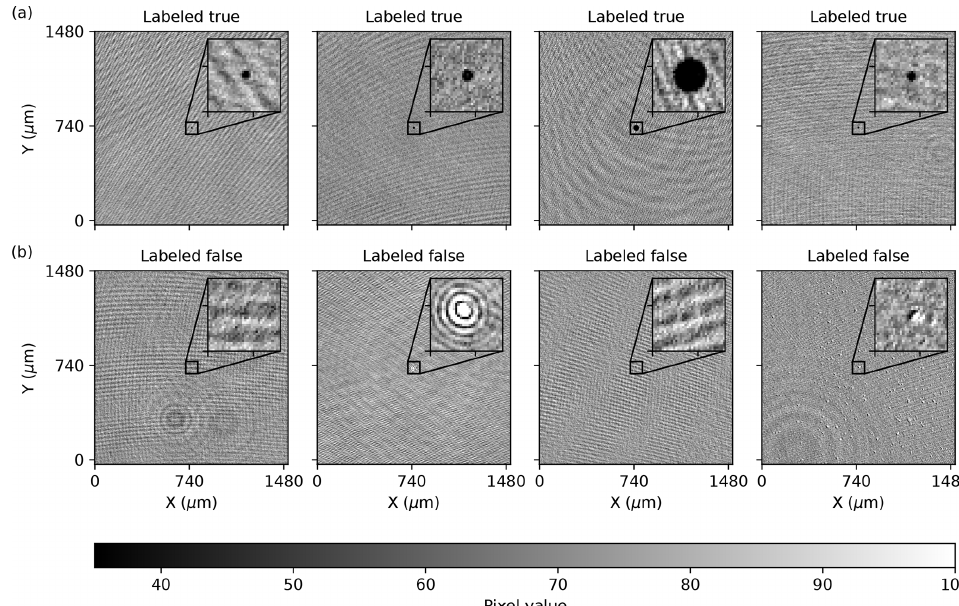
Figure 4. Examples of manually labeled, wave-propagated holograms. Panel (a) shows cases where the particle in the image was determined to be in focus (labeled true), while (b) illustrates cases where no particle was in focus. The second and fourth examples on the bottom illustrate reflection and what was determined to be an artifact, respectively. The insets highlight the center of each image. In all images the pixel values ranged from 0 to